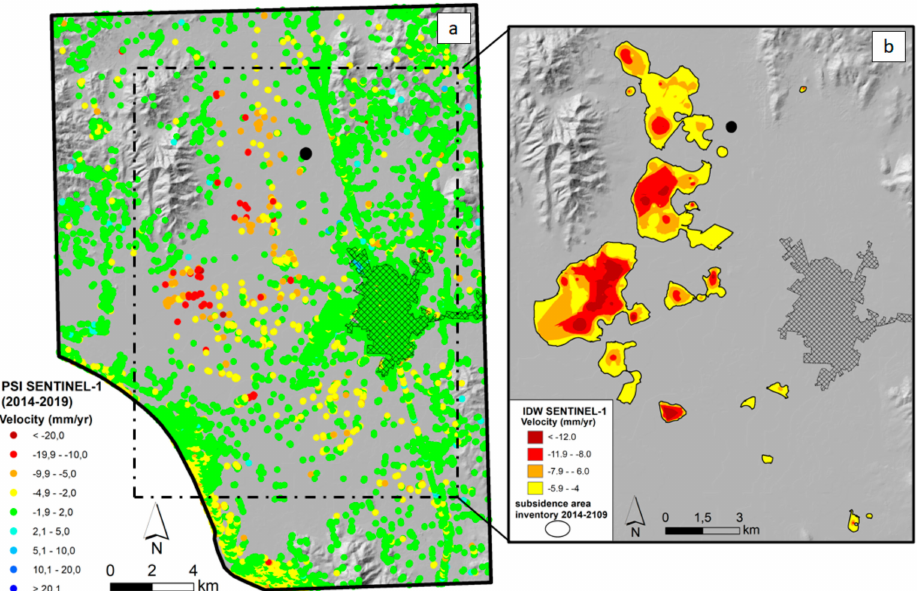
Figure 4. ( a ) Spatial distribution of mean annual velocities of merged ascending and descending SENTINEL-1 PSI data over the study area; ( b ) IDW raster map of SENTINEL-1 data and resulting polygonal extension of subsidence area inventory 2014–2019. The black circle represents the location of the sinkhole event in the Bottegone site in 1999. The checked pattern represents the Grosseto urban fabric.